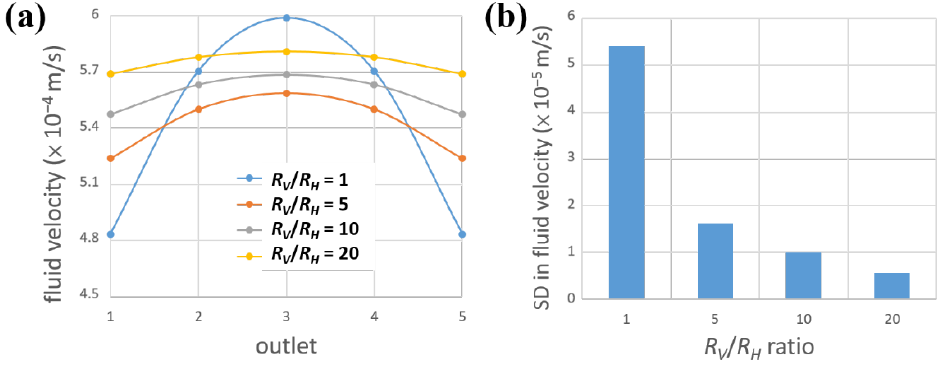
Figure 5. Simulation of fluid velocities for unmodified devices. ( a ) Fluid velocities in all outlets along red lines in Figure 4. ( b ) SDs in fluid velocities for four curves in ( a ).